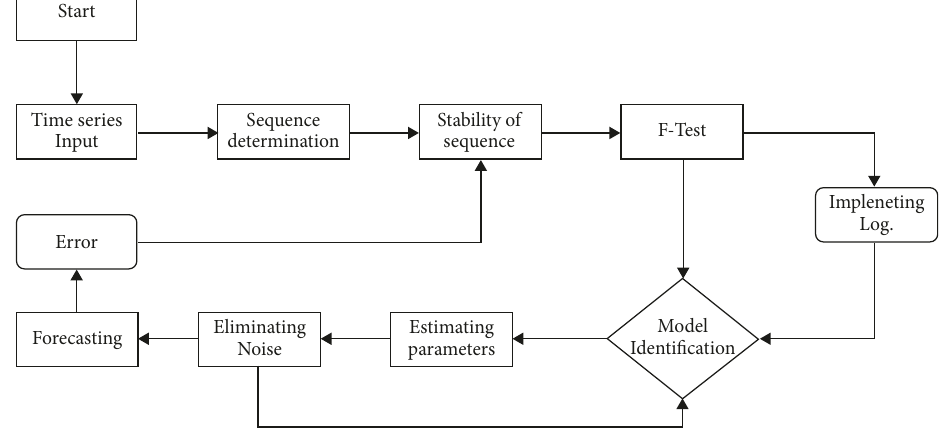
Figure 1: Flow chart of ARIMA Model used in this